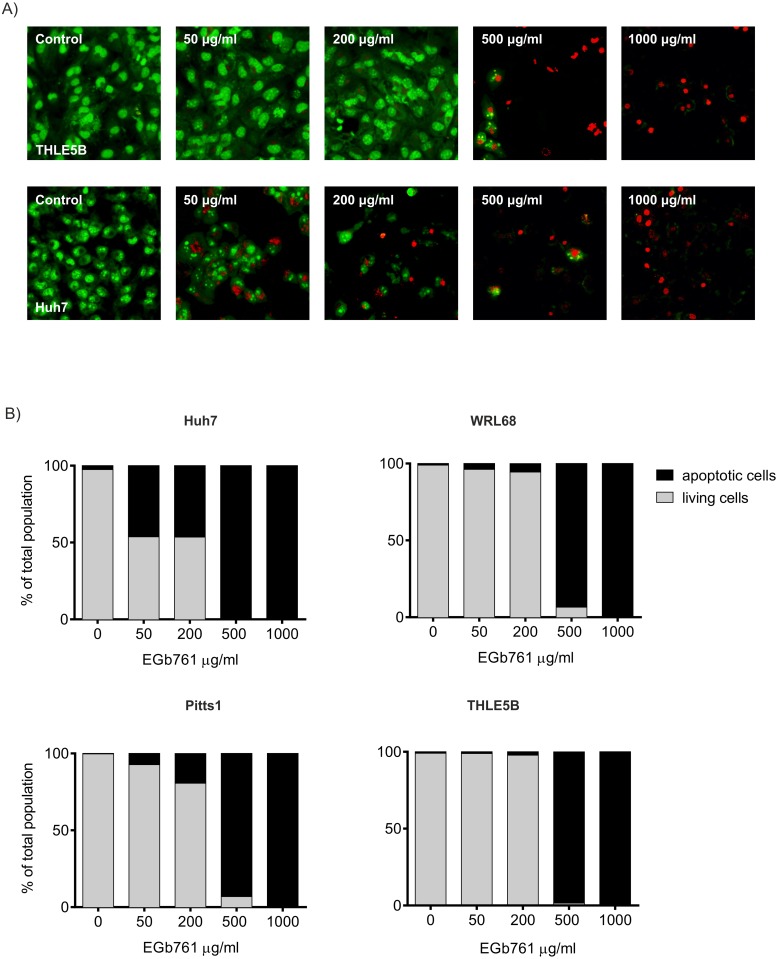
EGb761 induces apoptosis in all cell lines.(A) Representative confocal microscopy of double staining with ethidium bromide (EtBr, red) and acridine orange (AO, green) to quantify apoptosis in the absence or presence of different concentrations (0–1000 μg/ml) of EGb761 for three days in THLE5B and Huh7. (B) Quantification of apoptosis and expressed as a percentage of total population.